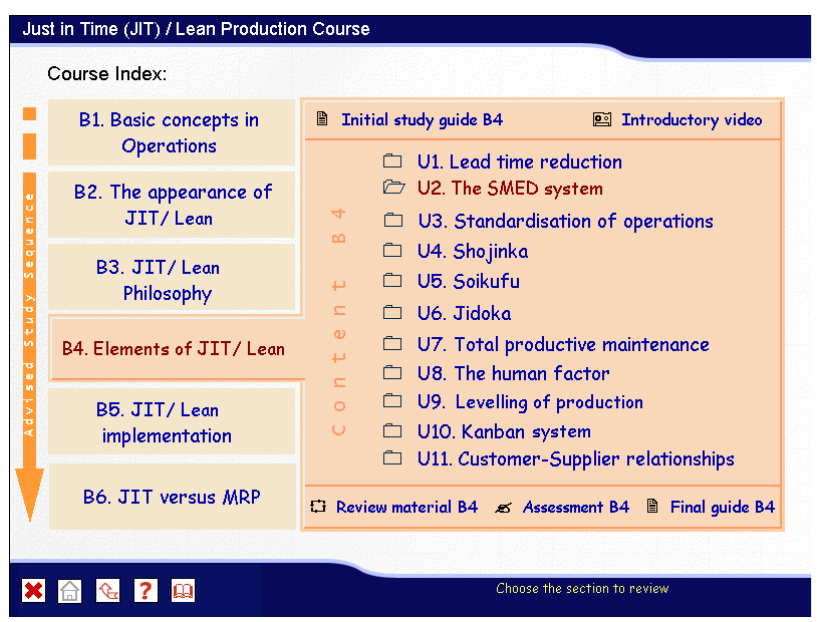
Figure 2. “Main or Blocks